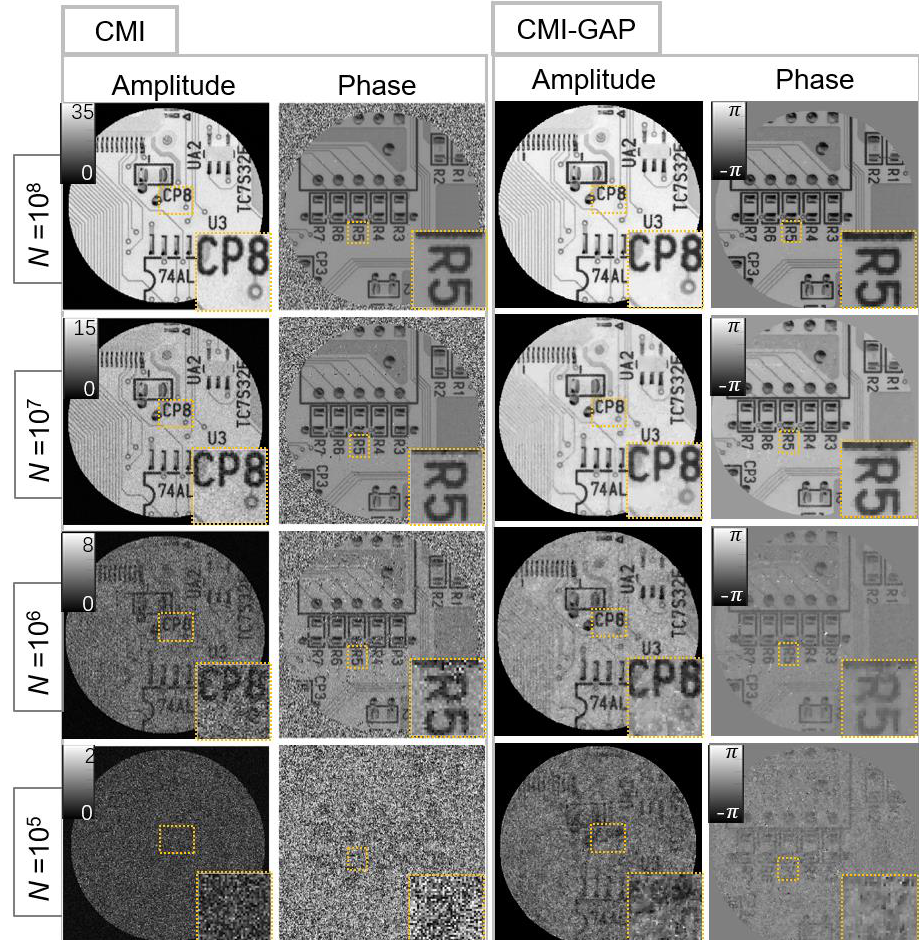
Figure 2. Reconstruction of the sample given near-field CMI simulated data at varying photon flux. In the lower right corner of each image is a larger version of the middle region. As 𝑁 decreases, the superiority of CMI-GAP is demonstrated clearly.